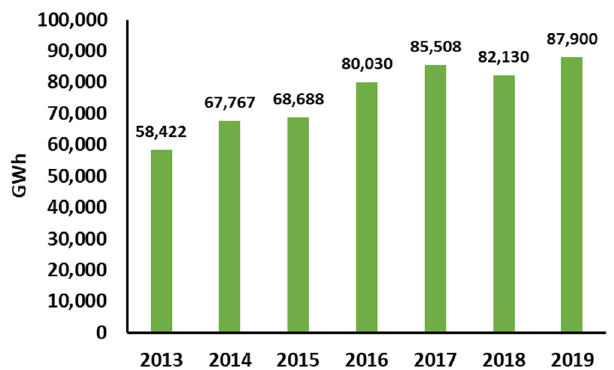
Figure 1. Cumulative annual values of electricity generated in Iraq in the period of 2013–2019 (data extracted from [28]).